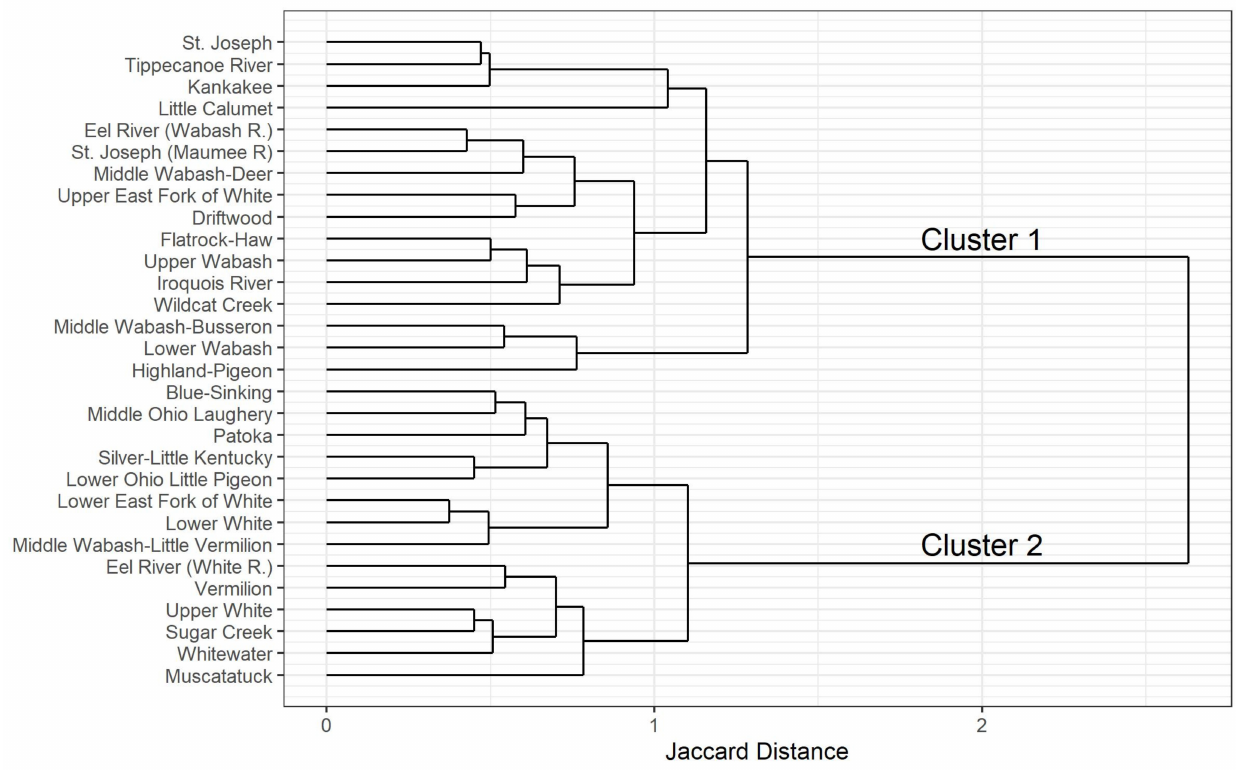
Figure 7. Hierarchical cluster tree based on K-means analysis of species by HUC8 drainage. Table 4. Models with ∆ AICc ≤ 2 and their variables (X), AICc score, ∆ AICc, AICc weights, and McFadden R 2